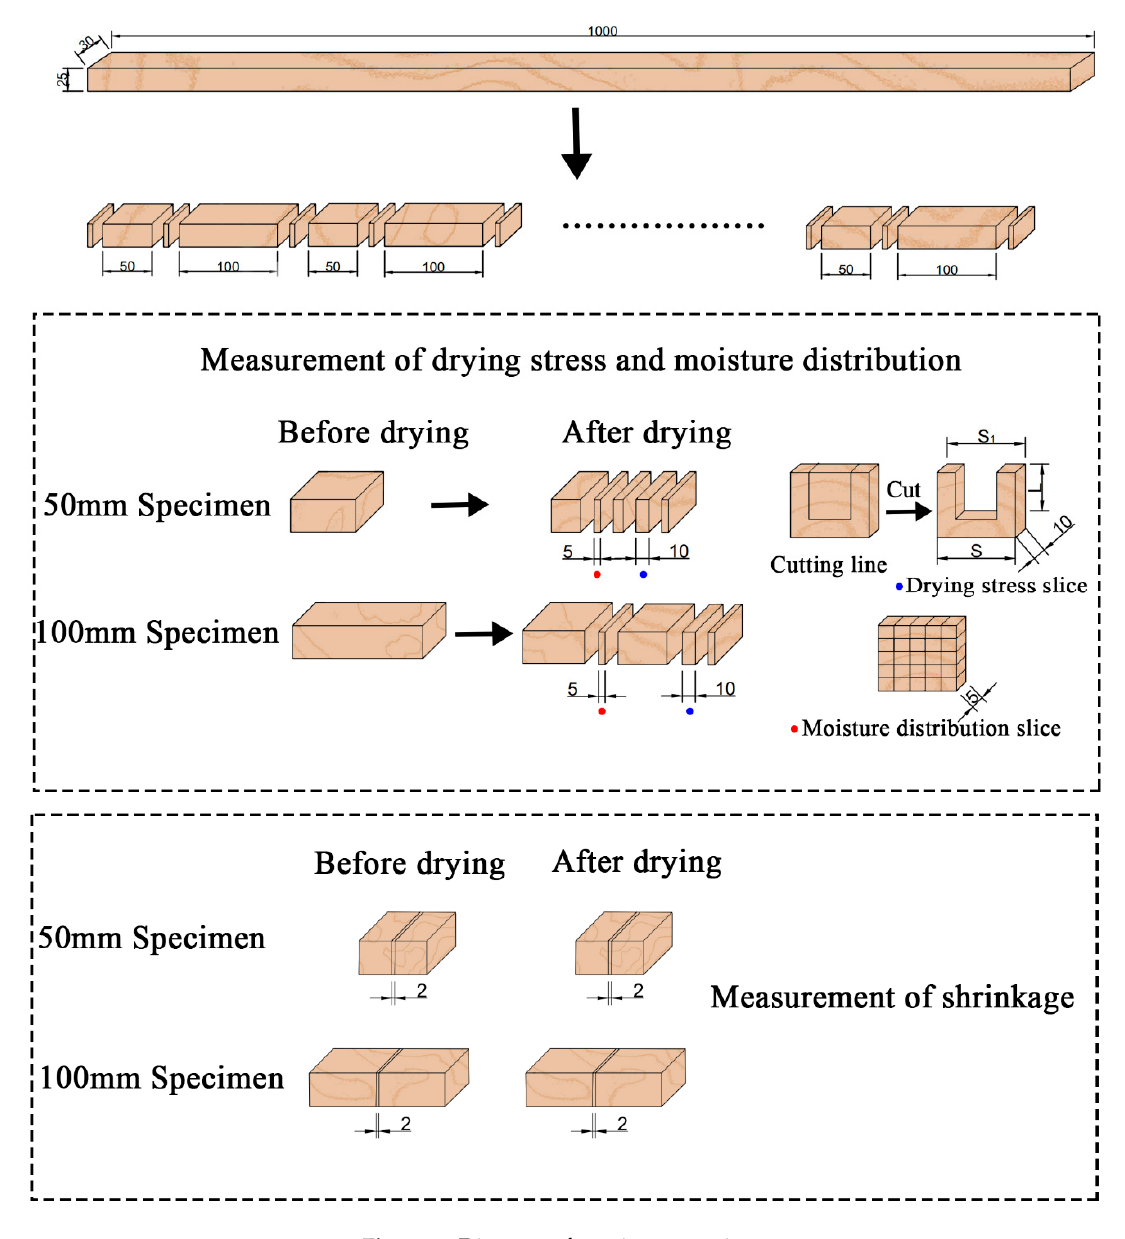
Figure 1. Diagram of specimens cutting.